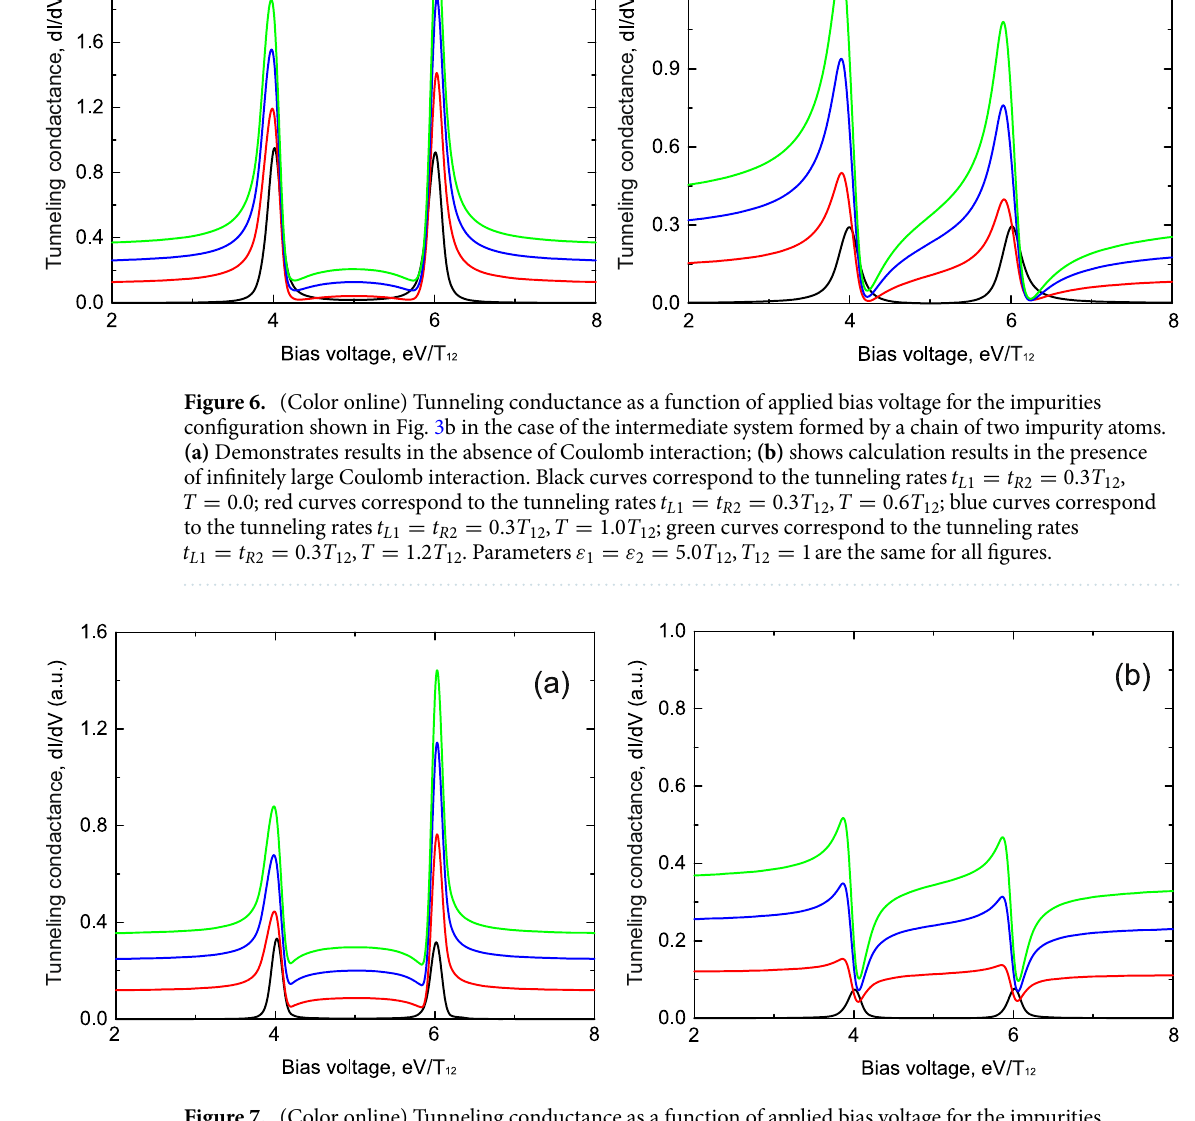
where ˆ n σ i = ˆ a σ + i ˆ a σ i and U i is the on-site Coulomb repulsion and i is the number of the impurity atom or quan- tum dot. To take Coulomb interaction into account one can use the expressions for the tunneling conductance obtained in the previous sections with the corresponding modification of Green’s functions. Now retarded and advanced functions depend on electron occupation numbers n i which should be determined from the calcula- tions. For brevity we present here only the case of very large Coulomb interaction U , i.e. when it strongly exceeds the single electron energies and the applied bias voltage. That means that only one electron with a fixed spin projection can be localised at the impurity energy level 56 .